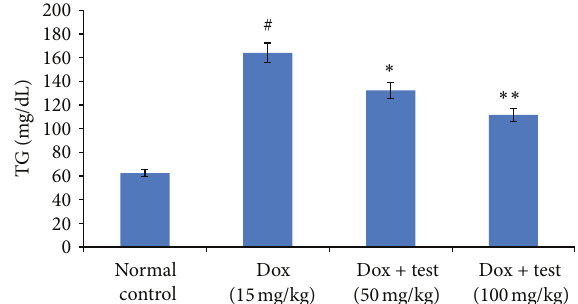
Figure 1: Effect of test compound on plasma CK-MB levels in rats treated with doxorubicin. # 𝑃 < 0.001 versus normal control; ∗ 𝑃 < 0.01 ; ∗∗∗ 𝑃 < 0.001 versus dox.